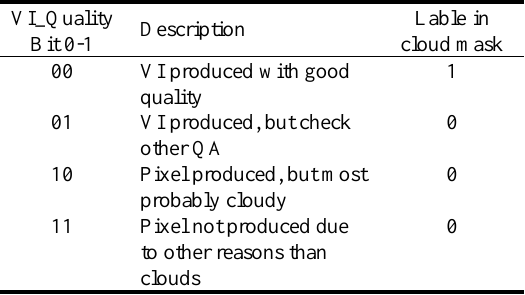
Table 1. Descriptions of the first two bits in VI_Quality.